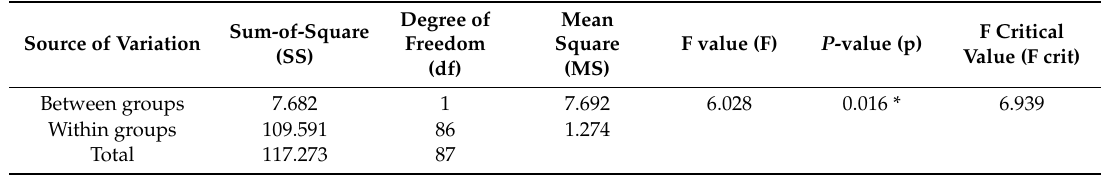
Table 3. Results of one-way ANOVA on the mean di ff erence between trail condition and the percentage of canopy coverage above the 44 sampling points in the study site. The significance di ff erence (p) was set at ≤ 0.05.